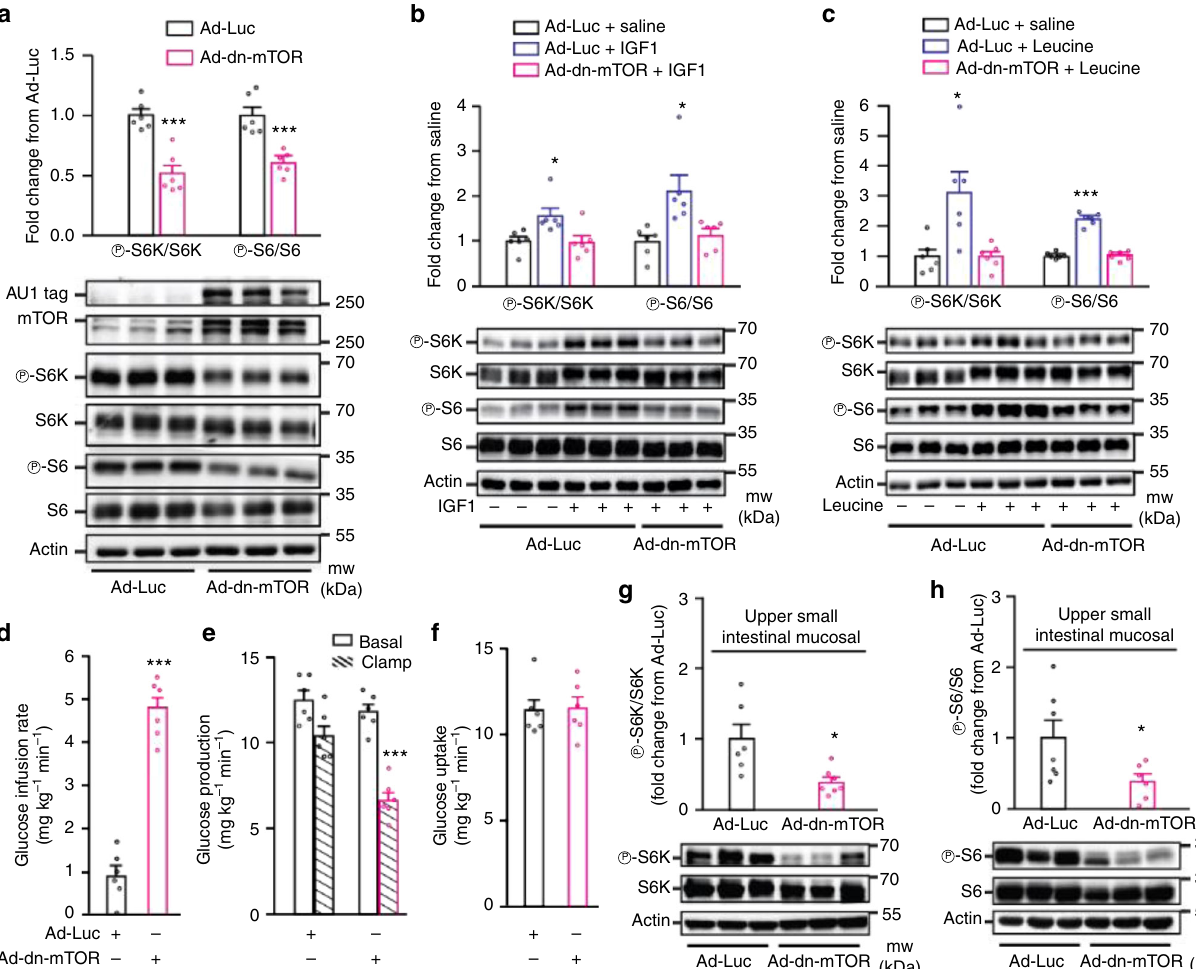
Fig. 2 Molecular inhibition of upper small intestinal mTOR lowers glucose production. a – c Representative western blot and quantitative analysis of phosphorylated S6K and S6 protein expression normalized to their respective total in PC12 cells infected with Ad-dn-mTOR and treated with saline ( a ), IGF1 ( b ), or leucine ( c ) compare to cells infected with Ad-Luc and treated with saline. AU1, tag protein for mTOR construct; actin, loading control. a *** p < 0.001 as calculated by unpaired t -test ( n = 6 for each group); b , c * p < 0.05 or *** p < 0.001 vs. all other groups as determined by ANOVA with Tukey ’ s post hoc test ( n = 6 for each group). d – f The glucose infusion rate ( d ), glucose production ( e ), and glucose uptake ( f ) during the clamp in HFD-fed rats with upper small intestinal Ad-Luc ( n = 6) or Ad-dn-mTOR ( n = 6). *** p < 0.001 vs. Ad-Luc as calculated by unpaired t -test. g , h Quantitative analysis and representative western blot of phosphorylated S6K ( g ) and S6 ( h ) protein expression normalized to their respective total in the upper small intestinal mucosal tissue of HFD rats with either Ad-Luc ( n = 6 for S6k, and 7 for S6) or Ad-dn-mTOR ( n = 7 for S6k, and 6 for S6). * p < 0.05 vs. Ad - Luc as calculated by unpaired t -test. Actin, loading control. Values are shown as mean ±